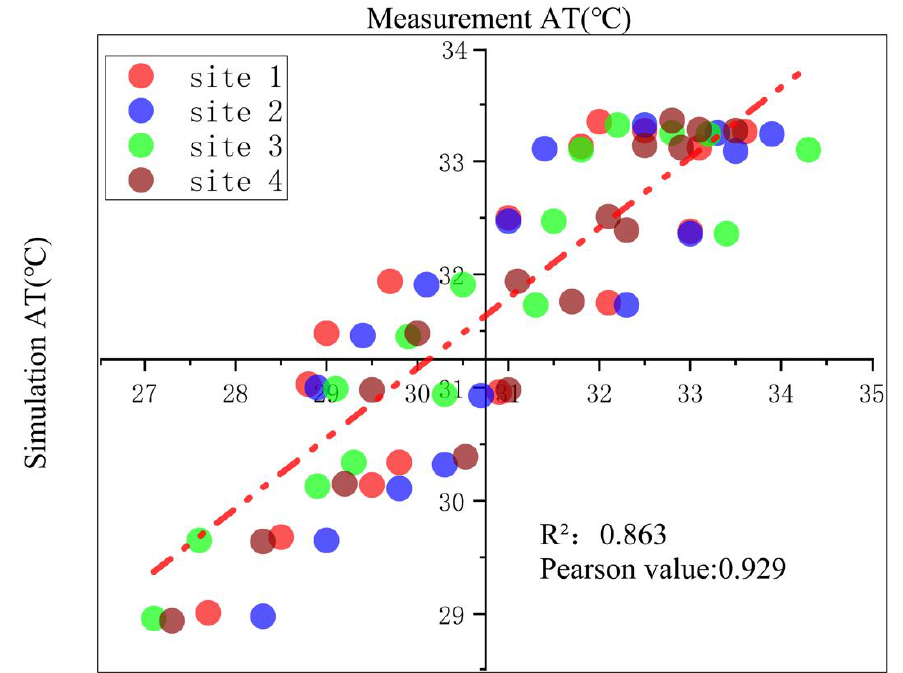
Figure 4. Correlation between the measurement (x-axis) and simulation (y-axis) data of air temperature on 21 July 2018. The AT of simulated and measured of the scattered points falling on the line are averaged; the red dashed line is the 1:1 line.